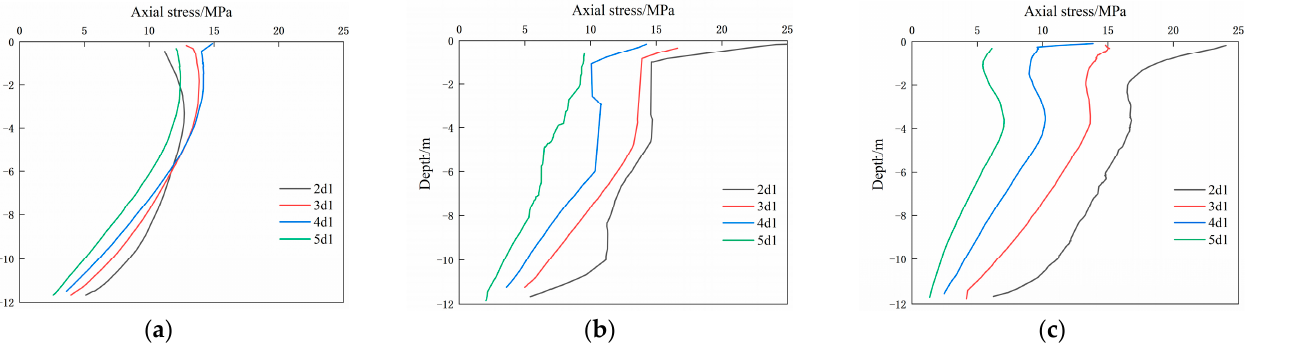
Figure 17. Axial stress of each pile in a pile group with different pile spacing. ( a ) Axial stress distribution of the central pile; ( b ) axial stress of the side pile; ( c ) axial stress distribution of the corner pile.